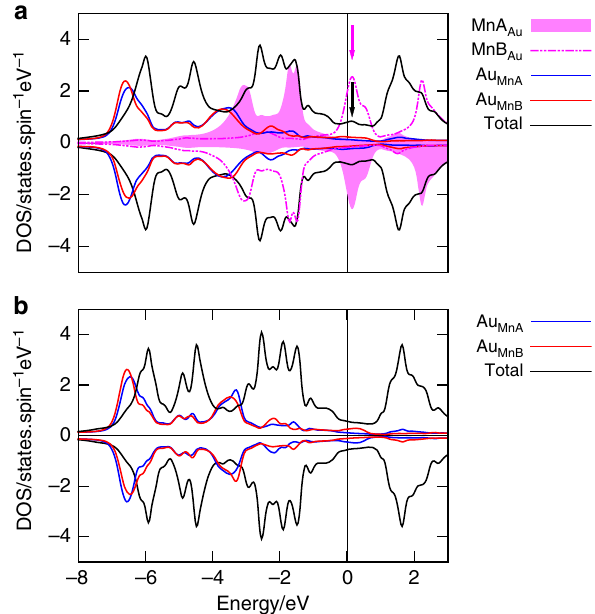
Fig. 6 Atom and spin resolved DOS as calculated ab initio. a Total and disordered atom resolved DOS of Mn 2 Au with 5% Mn – Au swapping. The magenta (black) arrow marks the virtual bound state in the Mn on Au site (total) density of states. b DOS of Mn 2 Au with 5% excess of